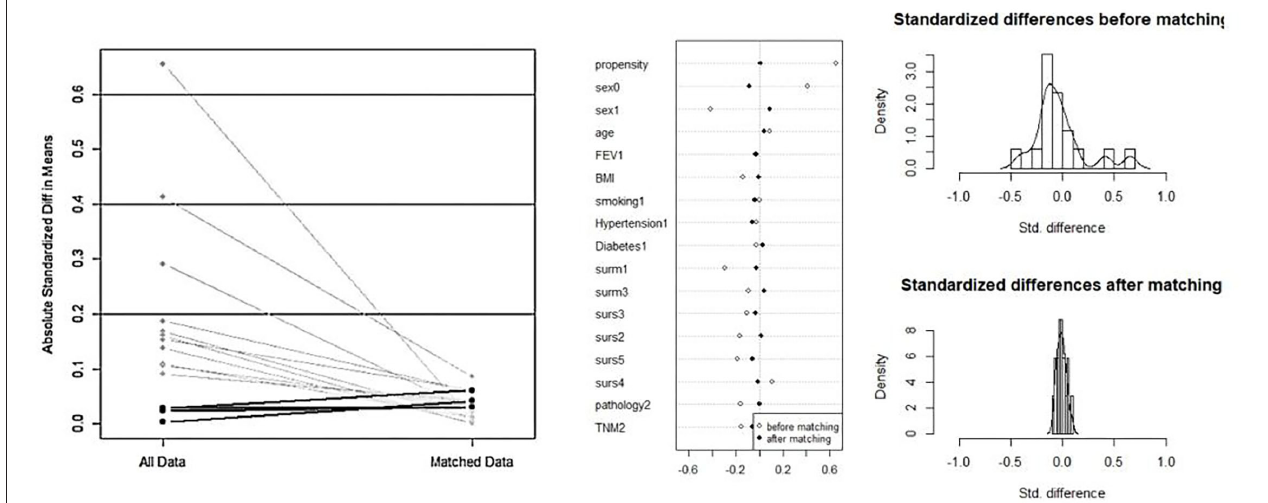
FIGURE 4 | The process of propensity score matching (PSM). After PSM, the clinical characteristics and baseline data between the two groups are matched and comparable.